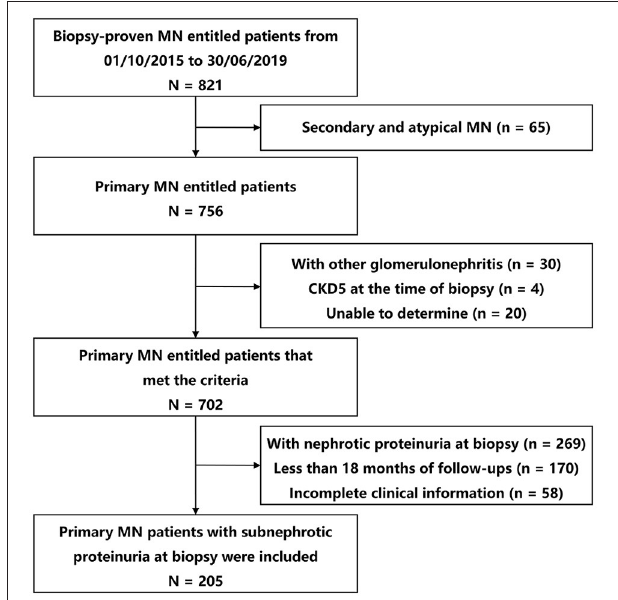
FIGURE 1 | Study flow diagram of patient selection. MN, membranous nephropathy; CKD, chronic kidney disease.